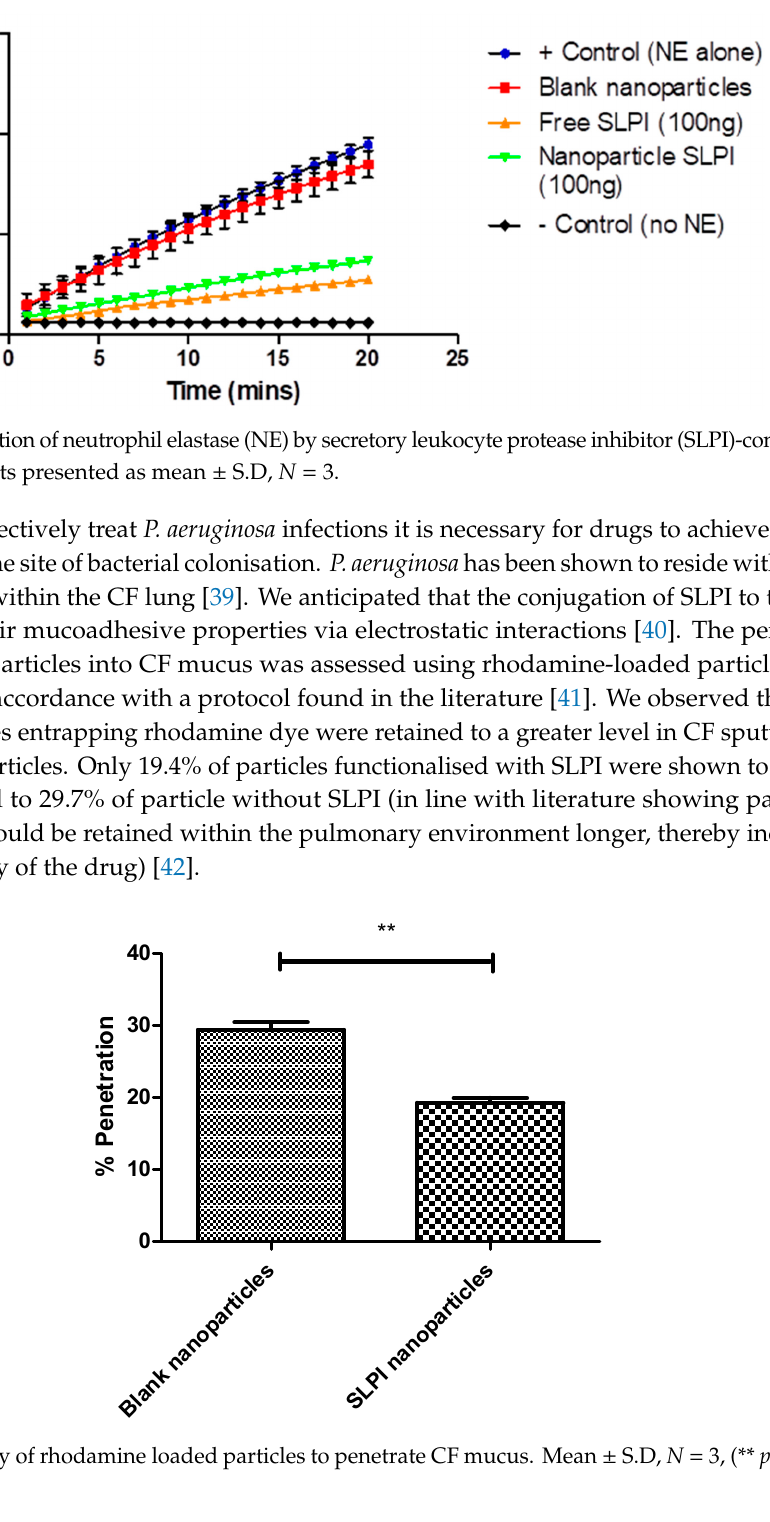
Figure 4. Ability of rhodamine loaded particles to penetrate CF mucus. Mean ± S.D, N = 3, (** p < 0.01).